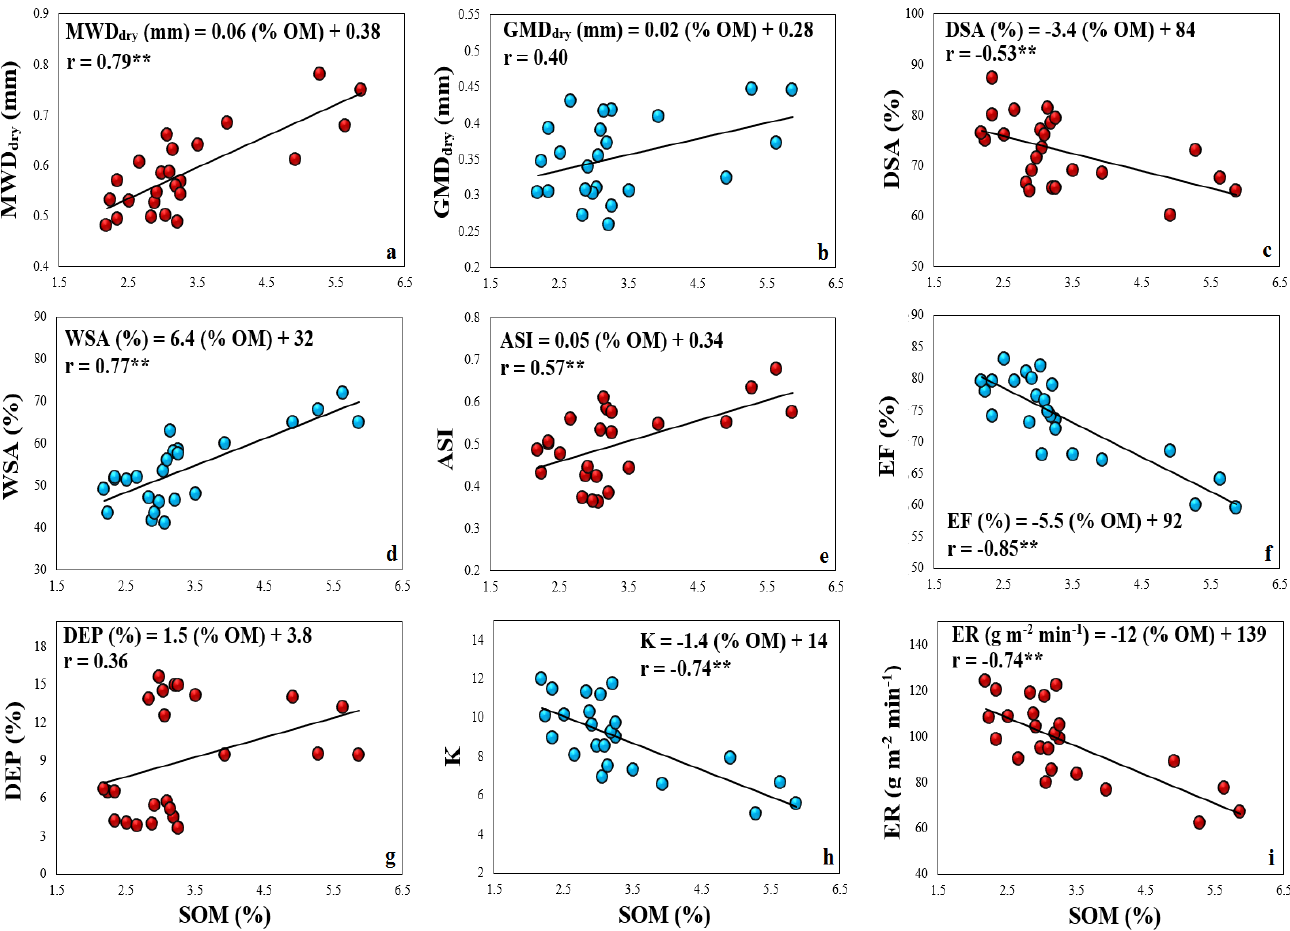
Figure 5. Relationship and correlation between SOM and MWD dry ( a ), GMD dry ( b ), DSA ( c ), WSA ( d ), ASI ( e ), EF ( f ), DEP ( g ), K ( h ), and ER ( i ). r shows correlation coefficient. * and ** are significant p < 0.05 and p < 0.01 correlations between variables, respectively.